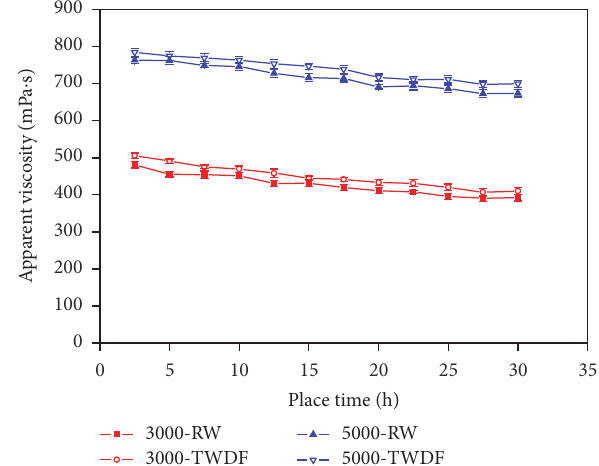
Figure 2: Effect of water quality on the viscosity of polymer solution with different concentration.